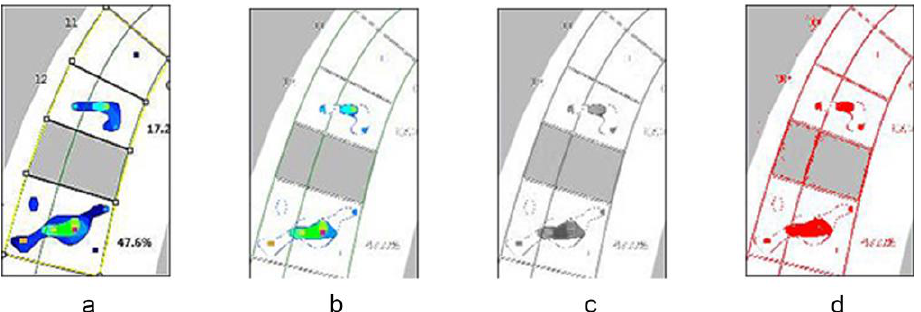
Figure 3. The T-scan graphical readouts were processed in a ( a – d ) step-wise process and analyzed in an image analysis software to eliminate artifacts from the readings.